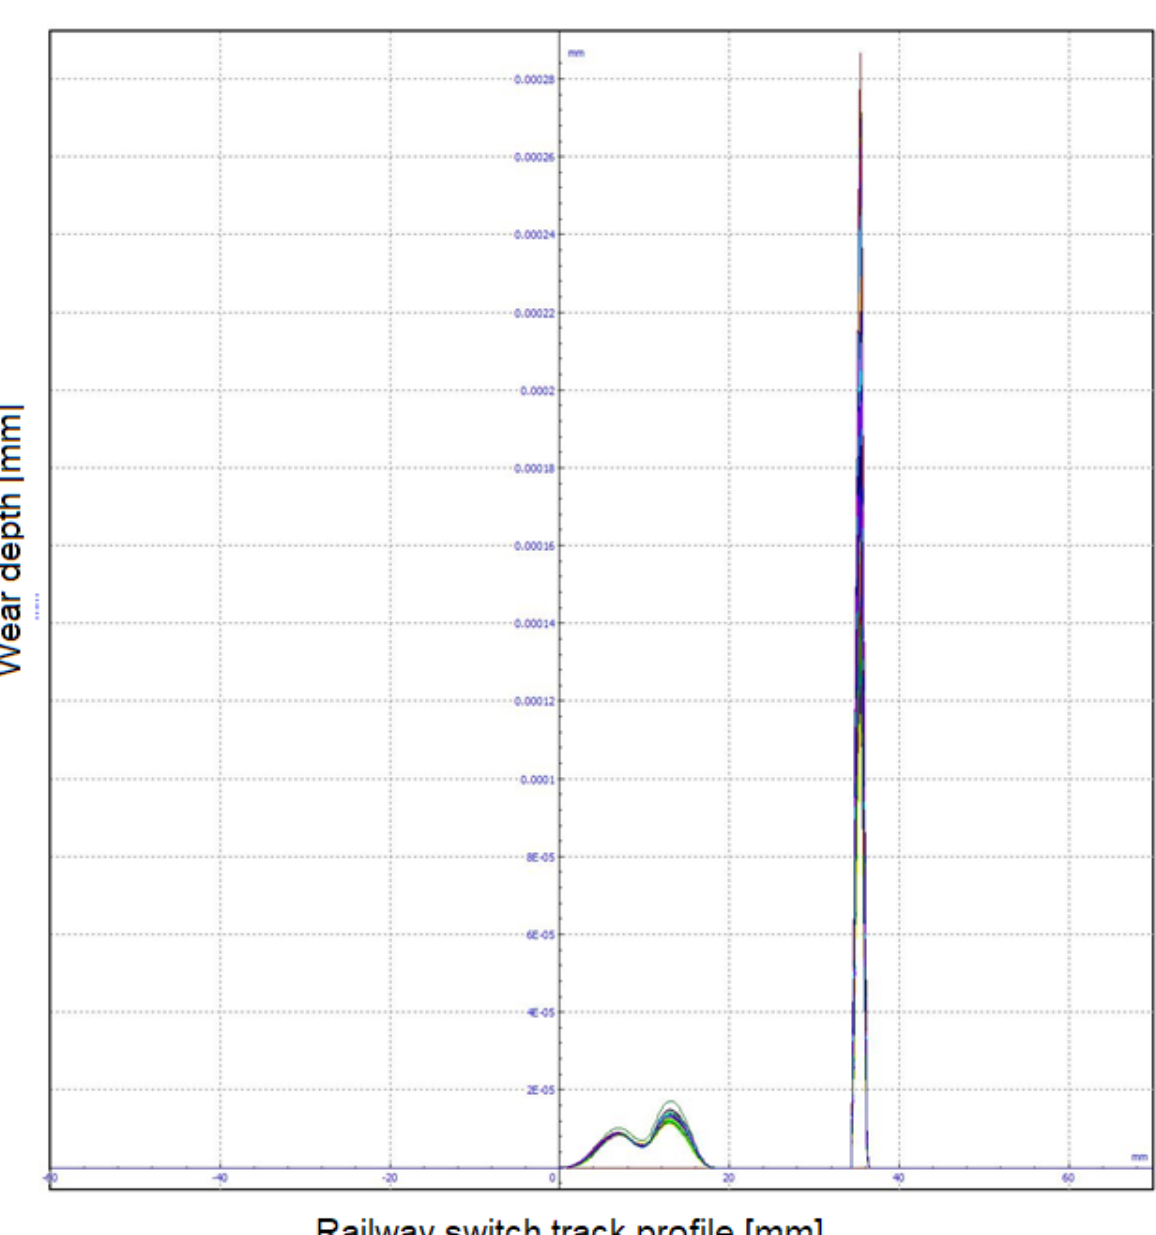
Figure 46. Wheel wear for a straight track without a turnout with constant stiffness obtained at 300 km/h.